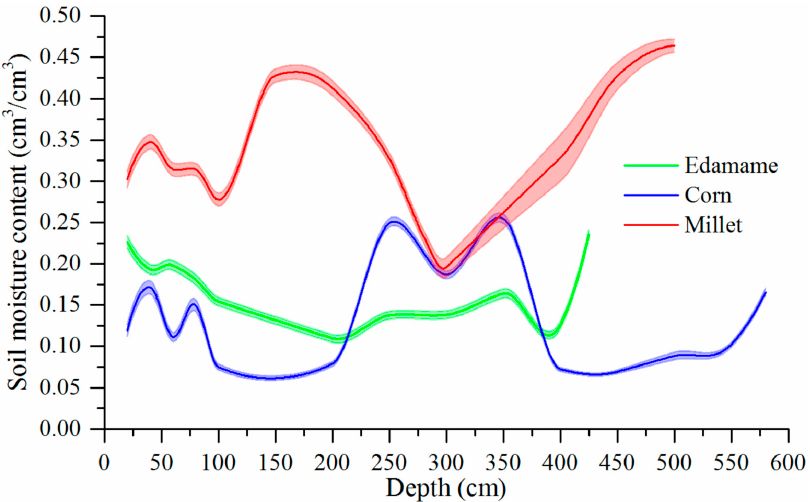
Figure 6. Relationship curves between mean soil moisture and depth of edamame, corn, and millet with color-filled error bars in the entire observation period.